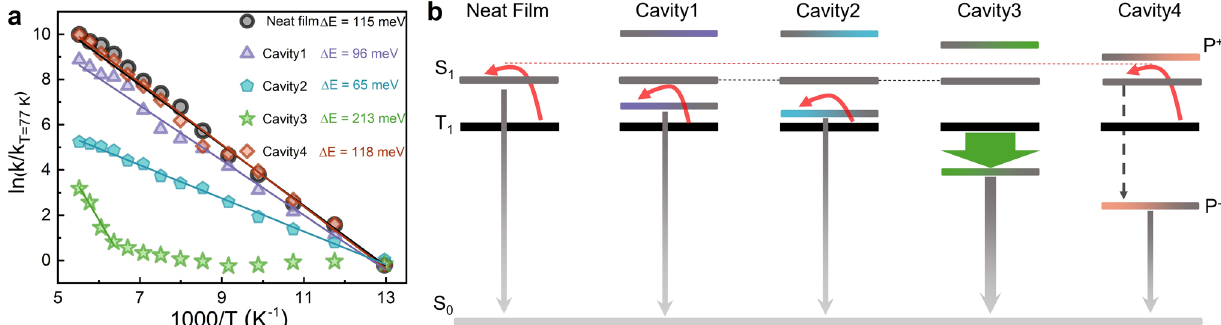
Fig. 4 Barrier-free RISC by strong coupling. a Arrhenius analysis with calculated activation energies for delayed P – (or singlet) emission inside and outside cavities. Lines show best fi t to Eq. 1. b Schematic illustration of the dynamics of the triplet to polariton (or singlet) transition at low temperatures. Red arrows represent thermally activated and green represents barrier-free RISC. The dashed black arrow indicates a relaxation from S 1 to P – , and the gray one represents delayed emission from S 1 or P –